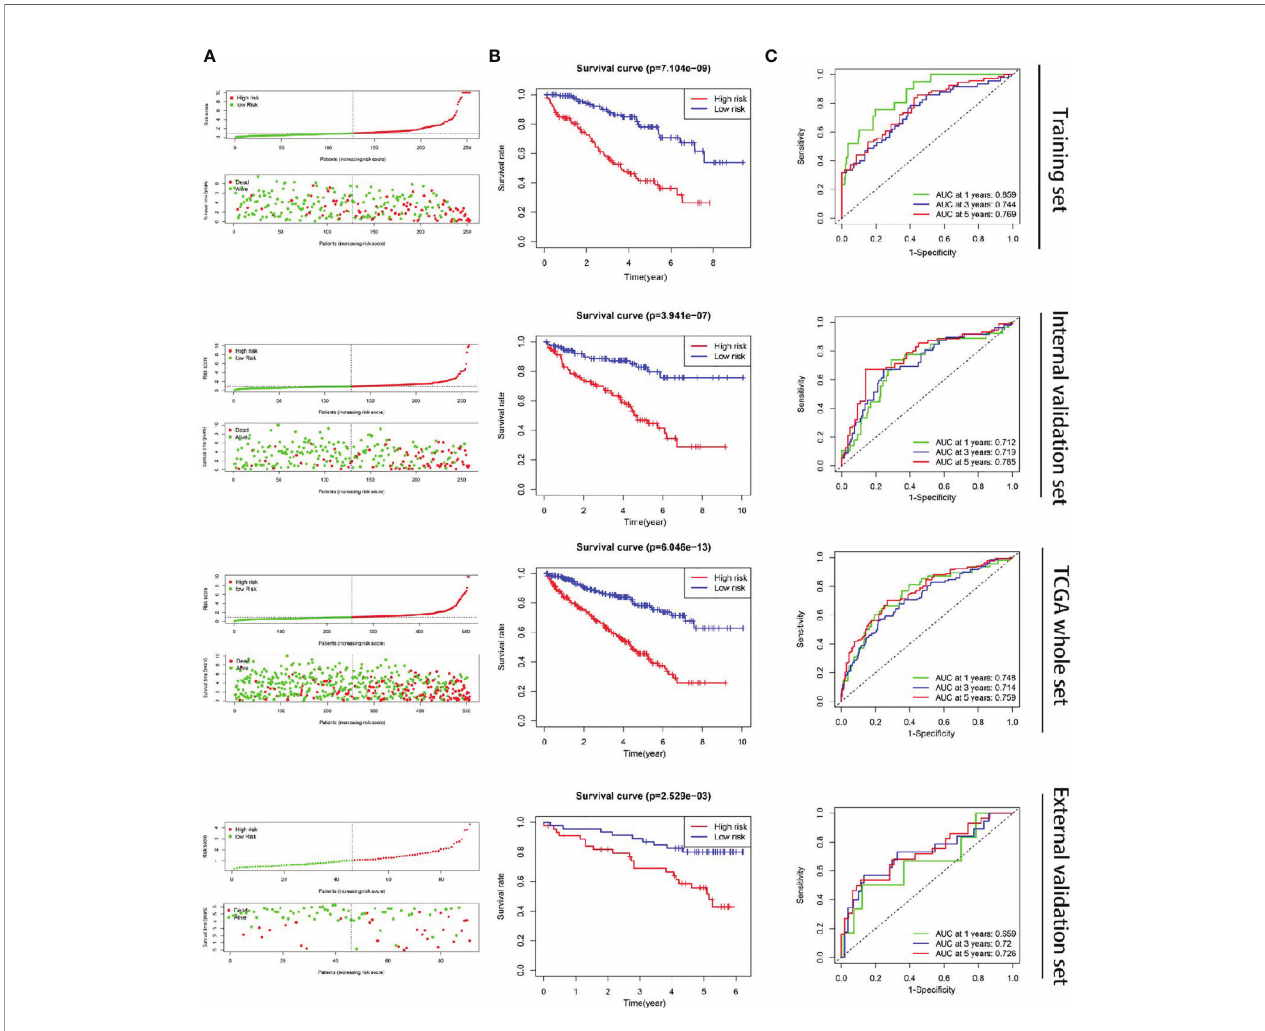
FIGURE 2 | Construction of the metastasis-related lncRNA signature in ccRCC. (A) The ccRCC patients were divided into two groups according to the risk score. (B) The OS period was longer in the low-risk group than that of the high-risk group. (C) The diagnostic ef fi cacy of the metastasis-related lncRNA signature was evaluated by the time-dependent ROC curves, in which all the AUC were more than 0.70 except for the “ 1 year ” of external validation